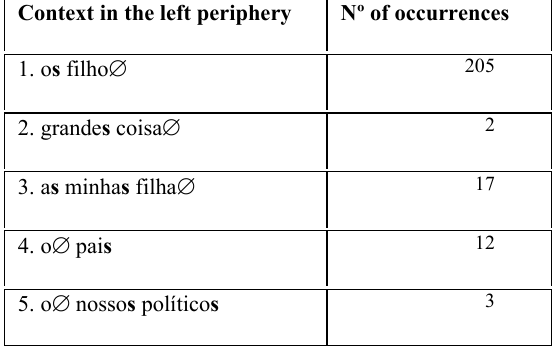
Table 3: Patterns of defective number agreement in the left periphery Context in the left periphery Nº of